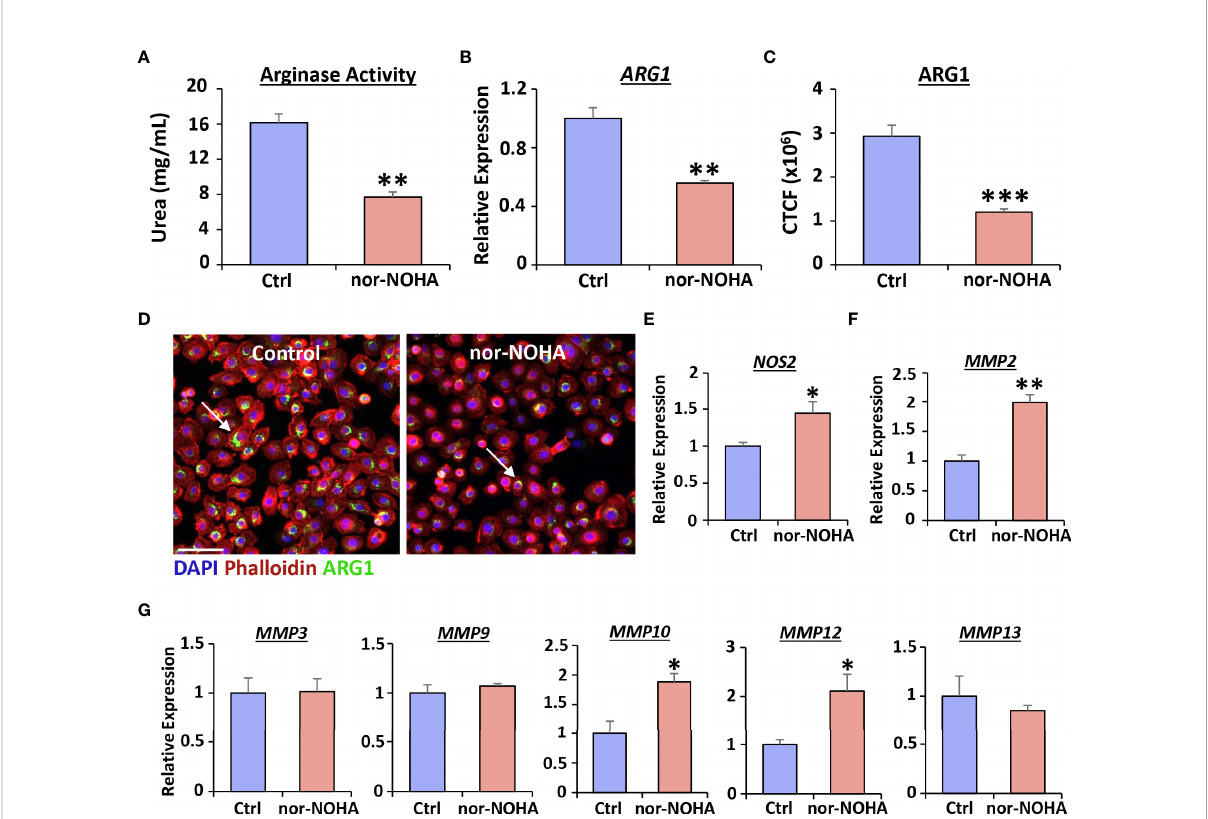
FIGURE 3 Nor-NOHA inhibits Arginase 1 and alters cytokine expression in human vaginal epithelial cells. An arginase activity assay was performed in VK2 cells following 24hr exposure to nor-NOHA (A) . Arginase 1 (ARG1) was assessed via qRT-PCR (B) and immuno fl uorescence (C) . CTCF = corrected total cell fl uorescence. Images in (D) ARG1 = Alexa Fluor 488. Rhodamine phalloidin = cytoskeleton. DAPI = cell nuclei. Bar = 100 µm. qRT-PCR for NOS2 (E) , MMP2 (F) and other MMPs shown (G) . Mean +/- SEM. Independent t tests performed. *= P < 0.05, **= P < 0.01 and ***= P <